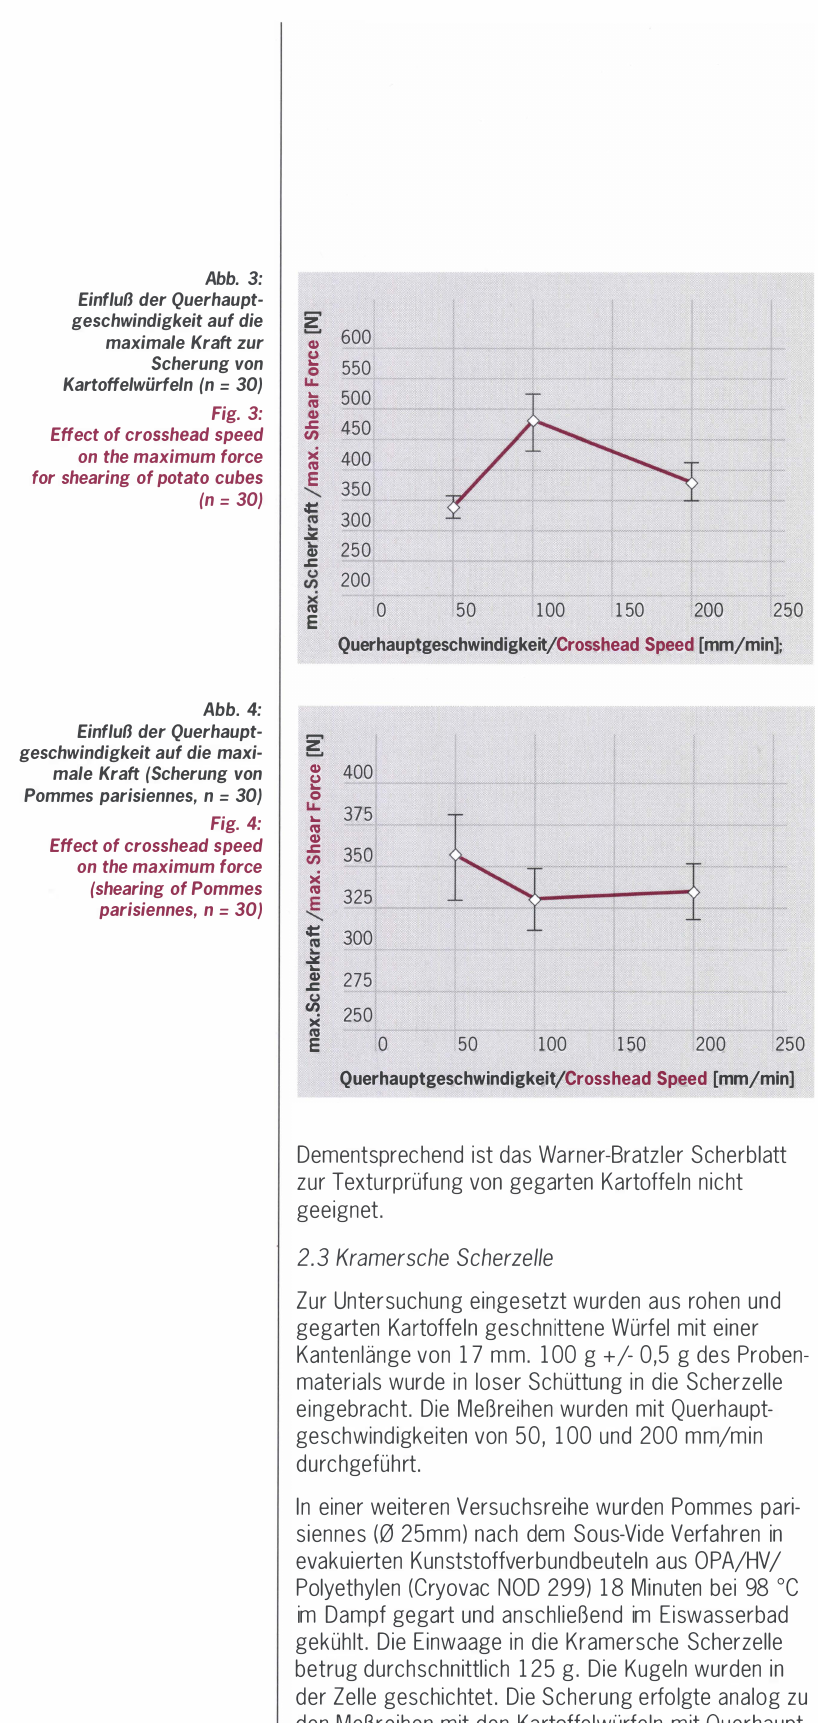
Fig. 3: Effect of crosshead speed on the maximum force for shearing of potato cubes